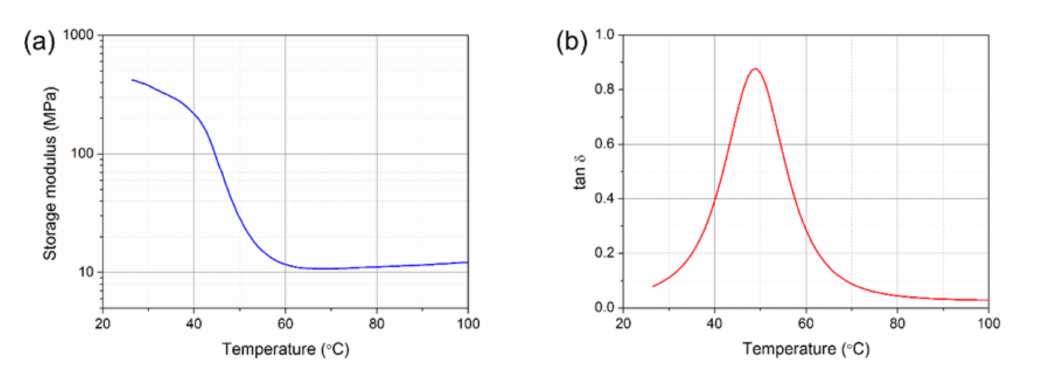
Figure 3. ( a ) Storage modulus and ( b ) damping factor (tan δ ) as a function of temperature for the UV-casted thiol-ene